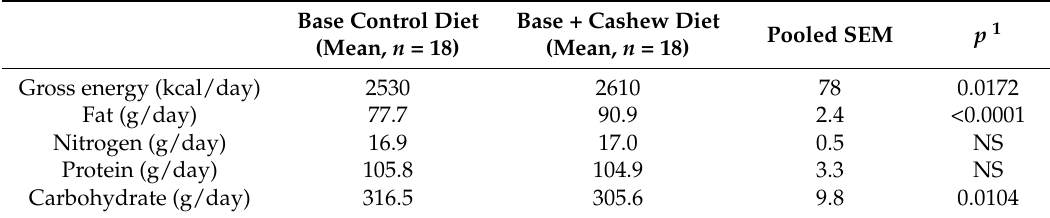
Table 3. Gross energy and macronutrient intake of diets for the Base Control Diet and the Base + Cashew Diet.